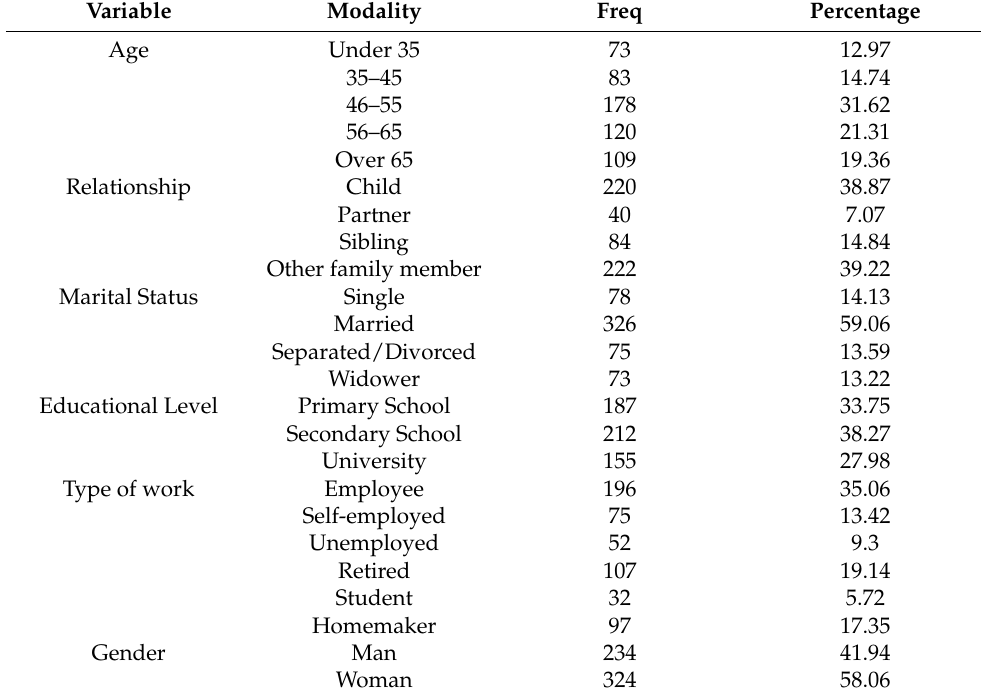
Table 3. Sample composition.